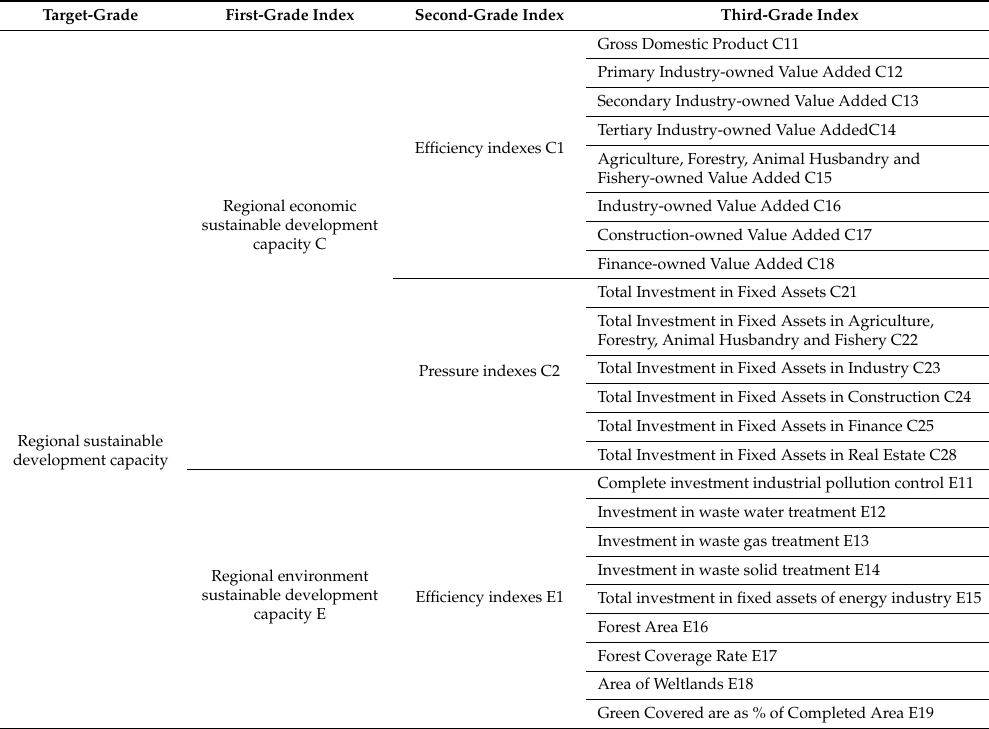
Table 1. Index system used to evaluate sustainable